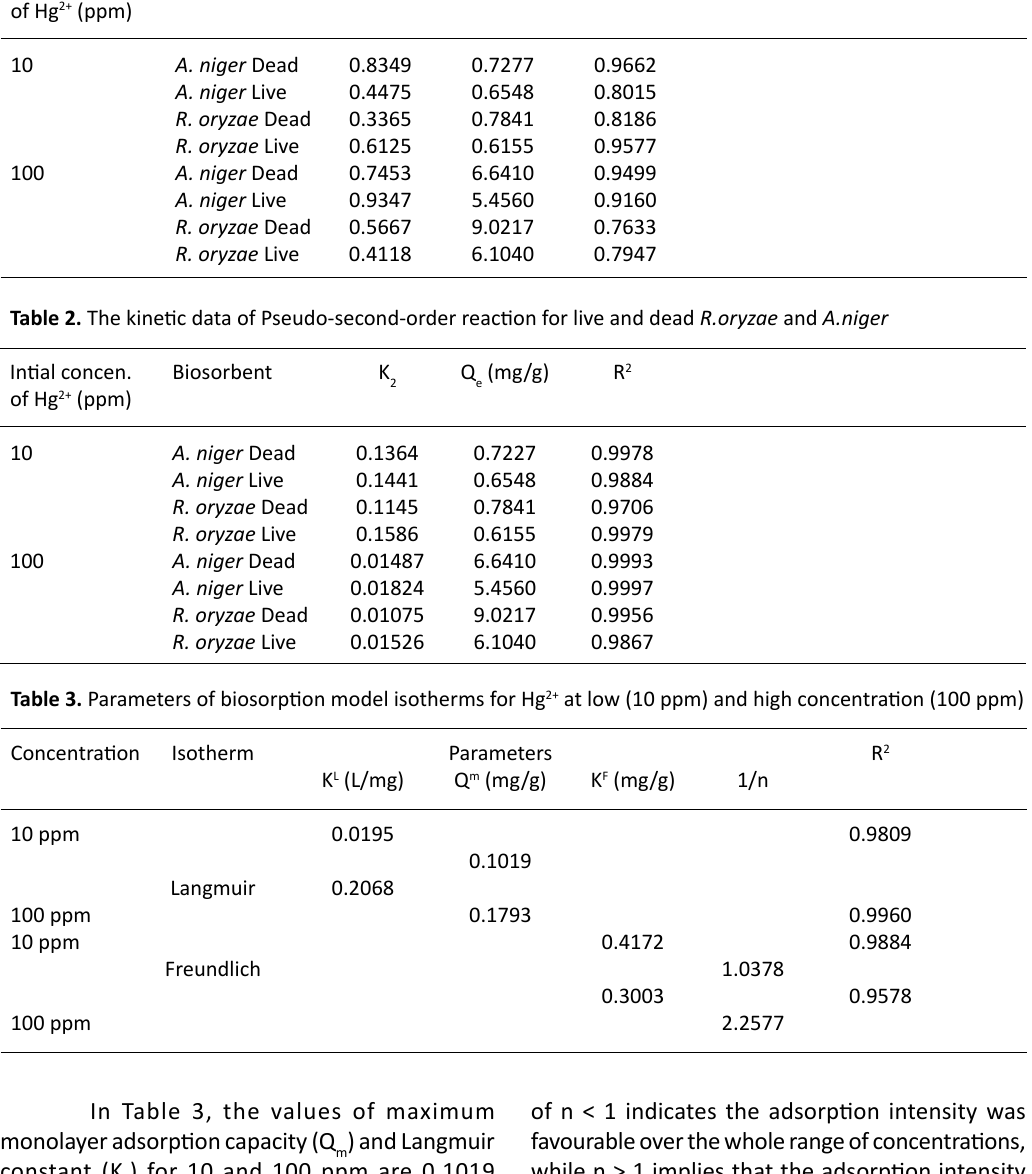
Table 1. The kinetic data of Pseudo-first-order reaction for live and dead R.oryzae and A. niger Intial